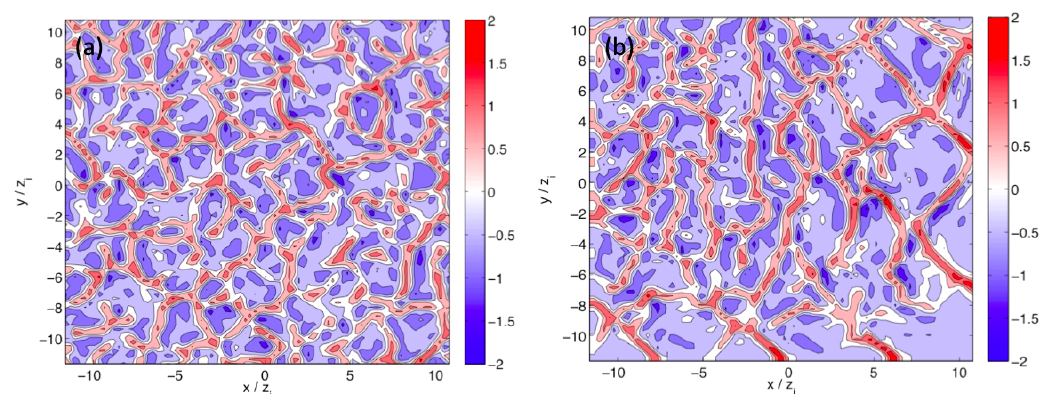
Figure 4. Horizontal contours of vertical velocity from: ( a ) a periodic 400-m resolution run; and ( b ) the 400-m run nested within a 1200 m periodic domain. Slices taken at z / z i = 0.1 at approximately the onset of convection for the periodic 1200 m run. Adapted from Zhou et al.